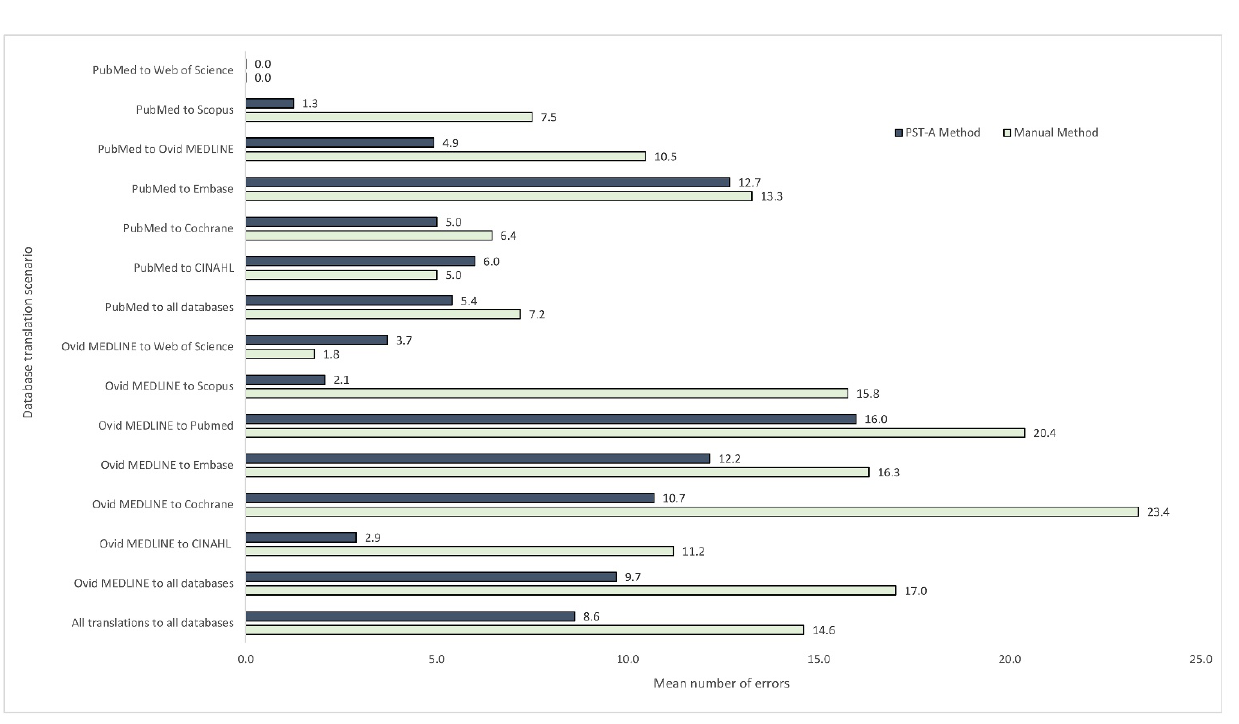
Figure 2 Mean number of errors by the PST-A and manual methods